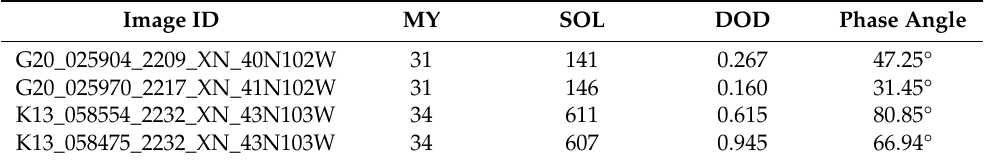
Table 3. CTX images used in this work. Dust Optical Depth (DOD) in the visible wave- length range from Montabone et al. [33] and Montabone et al. [34]. Region of interest: latitude and G20_025970_2217_XN_41N102W were used for generating the initial stereo